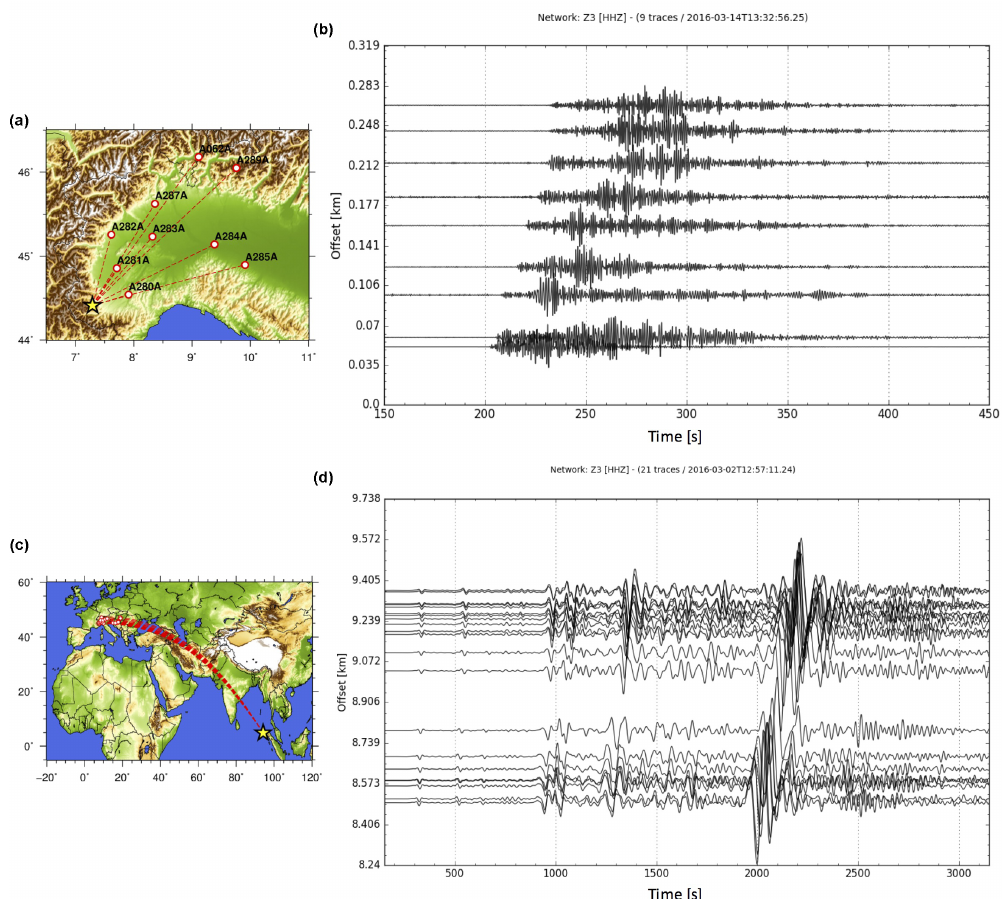
Figure 8. Examples of waveforms recorded by the Swiss-AlpArray temporary stations. (a) Location of the M3.5 local earthquake occurred the 14-03-2016 and of the recording station (b) associated waveform filtered using a high-pass filter with corner frequency of 0.4Hz; (c) Location of M7.8 teleseismic event occurred the 2 March 2016 in Sumatra and (d) recorded signals, bandpass filtered with corner frequencies of 0.008 and 0.05Hz.